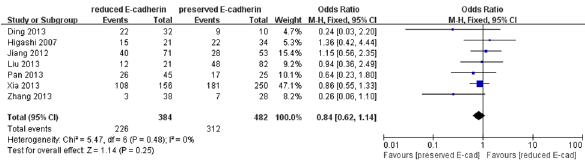
Figure S2 Funnel plot to assess publication bias. a.